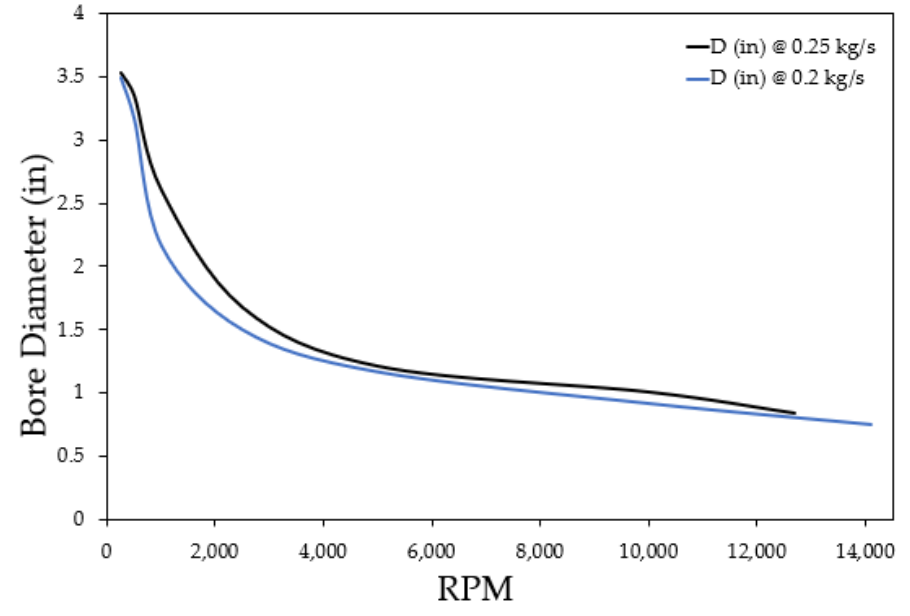
Figure 4. Piston bore diameter vs. RPM at various flow rates.